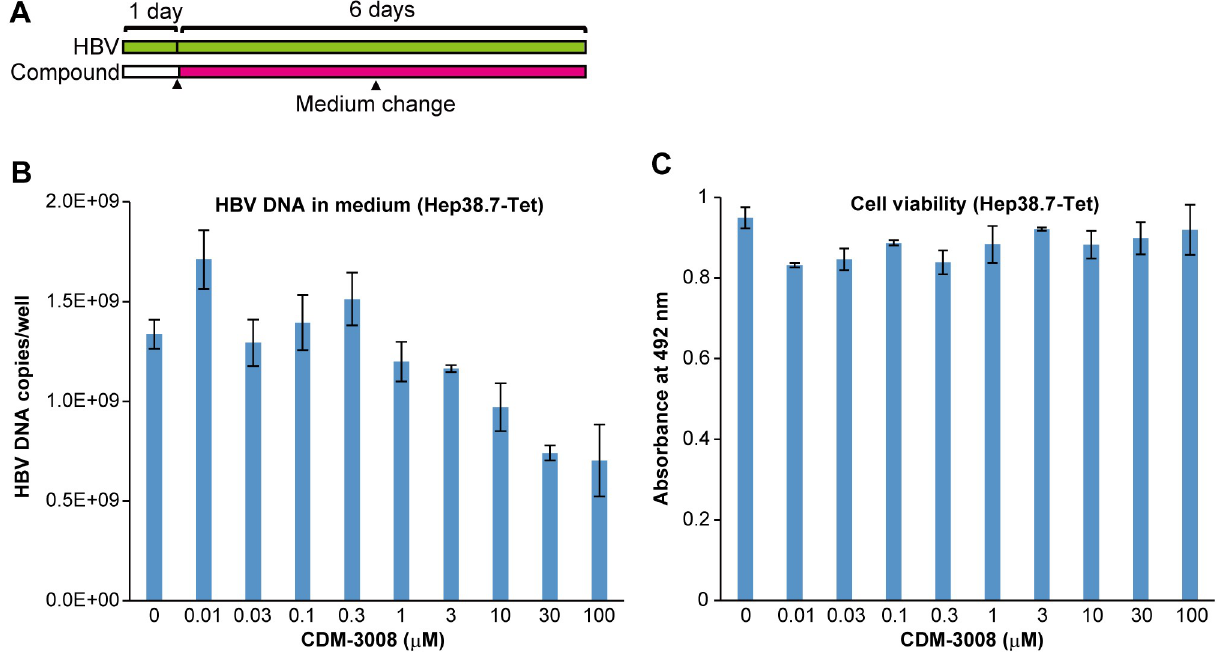
Fig 3. Analysis of anti-HBV activity in HepG2-derived cells. (A) Schematic experimental design of the anti-HBV activity analysis. Hep38.7-Tet cells were cultured for 1 day; the cells were then treated with 0–100 μ M CDM-3008 for 6 days (magenta). The black triangles show the times at which the medium was changed. (B, C) Hep38.7-Tet cells were treated with serially diluted CDM-3008 (0–100 μ M) for 6 days. After 6 days of treatment, the HBV DNA levels in the cell culture medium were measured by qPCR (B), and cell viability was measured by XTT assay (C). The error bars in B, C indicate S. D. (n =